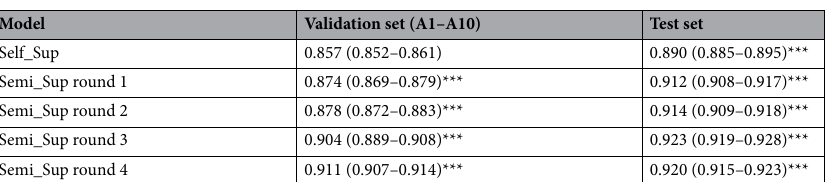
Table 4. AUC and 95% C.I. on the validation and test sets. Differences between each SSL round and the Self_ sup baseline were tested for statistical significance. Asterisks (*) indicate p value < 0.05 (*), p value < 0.01 (**), and p value < 0.001 (***),